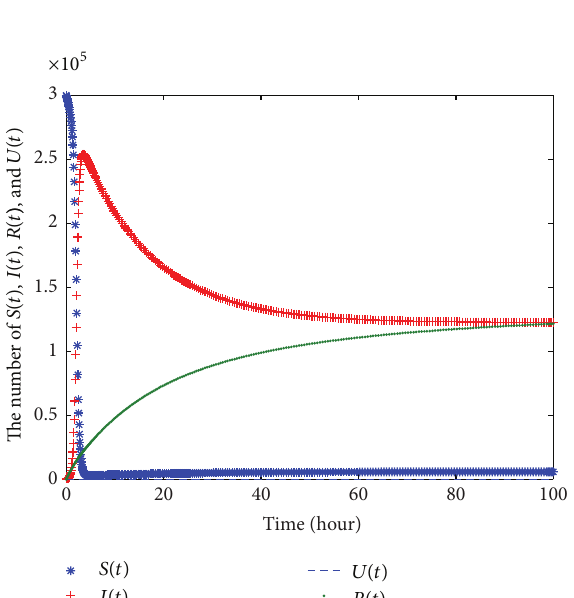
Figure 20: No infection status.